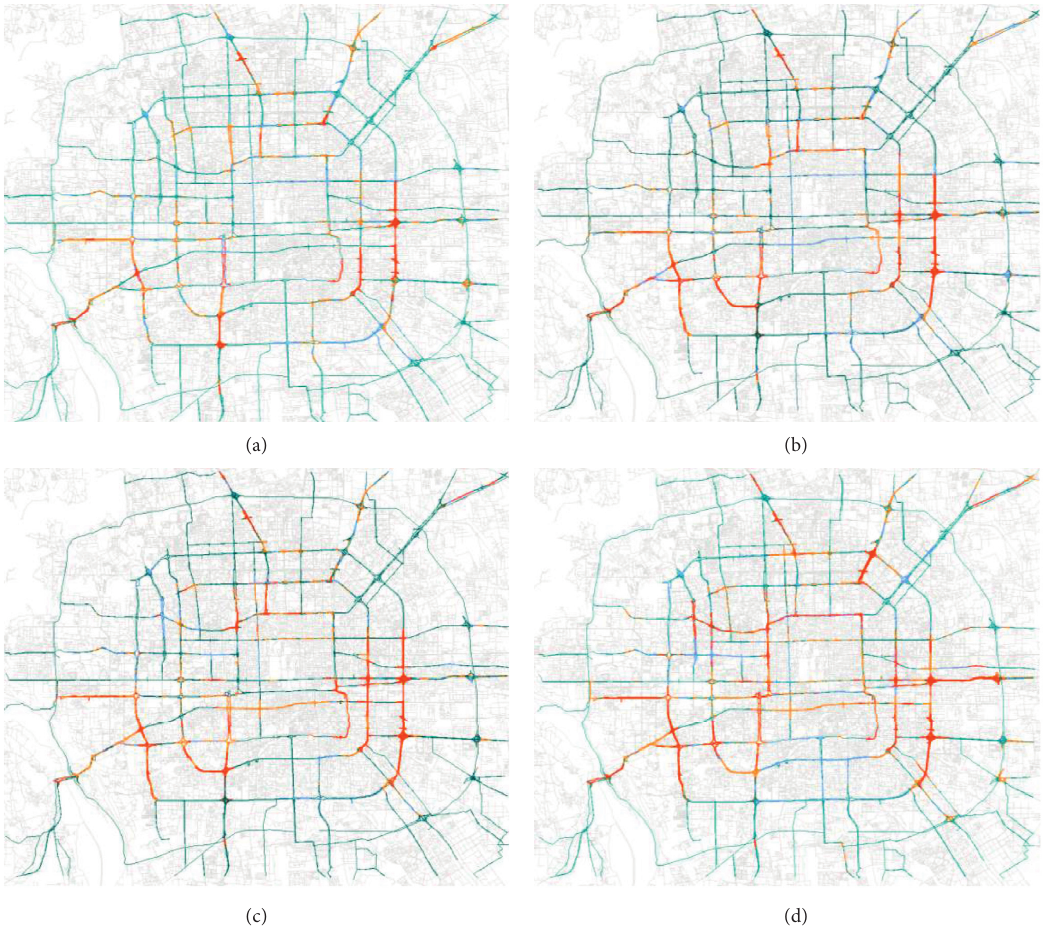
Figure 9: The traffic status prediction results. (a) 7:00 a.m., (b) 7:20 a.m., (c) 7:40 a.m., and (b) 8:00 a.m.